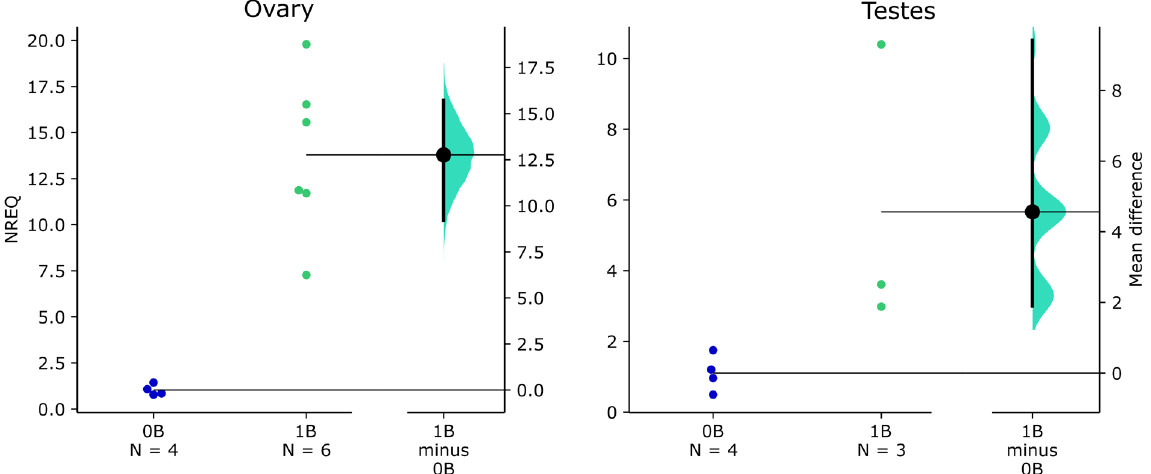
Figure 5 – Gardner-Altman estimation plots showing msh4 transcription levels in 0B and 1B individuals, as analyzed by RT-qPCR. Both groups are plotted on the left axes, and the mean difference (effect size) is plotted on a floating axe at the right as a bootstrap sampling distribution. The mean difference is depicted as a black dot, and the 95% confidence interval is indicated by the ends of the vertical error bar. NREQ = normalized relative expression